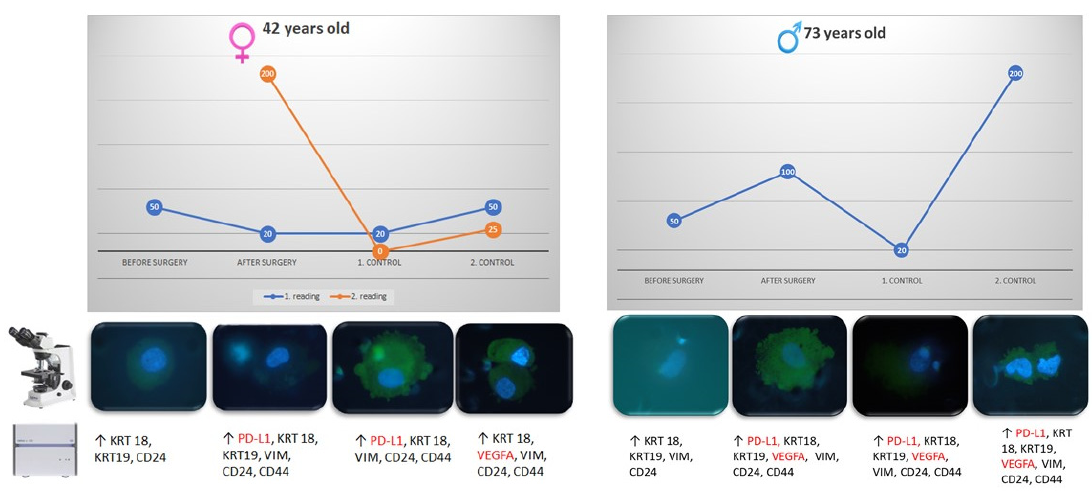
Figure 7. Gene expression analysis of CTC showing differences between the CTC PDL1+ (brown) and CTC PDL1- (violet). The arrows indicate genes expressed differentially between tested groups.